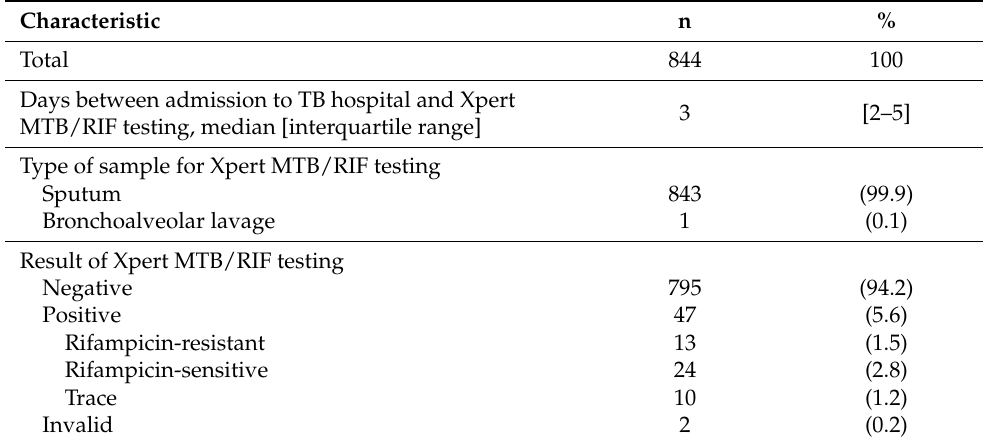
Table 3. Characteristics of laboratory TB testing among patients with COVID-19 admitted to repur- posed departments in TB hospitals, Belarus, April–November